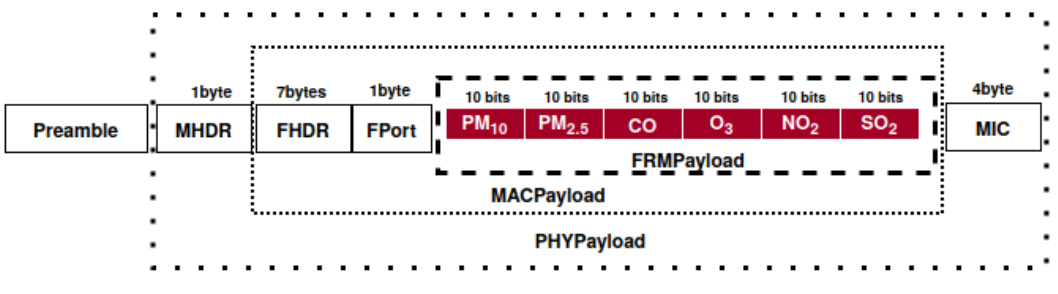
Figure 8. Format of a Monitoring